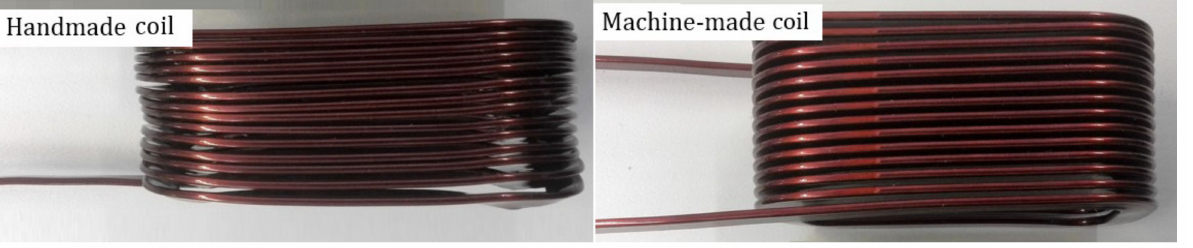
Figure 26. Automated coil forming versus manual coil forming